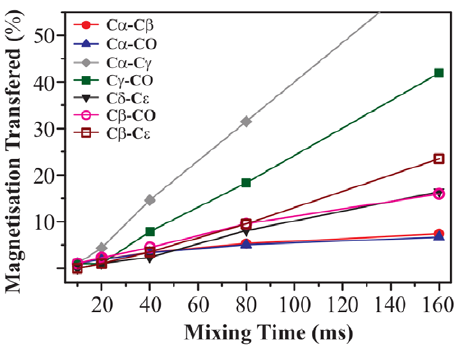
Figure 10. Mixing-time effect. Effect of mixing-time period on magnetisation transfer efficiency for different cross-peaks of U- 13 C-, 15 N- L-histidine : H 2 O at 11.74 T. For each cross-peak, M values were calculated for each mixing time using Eq. 1. All M values obtained for a particular cross-peak are normalised with respect to that obtained at t m =10 ms in case of C a -C b , C c -CO, C a -C c , C a -CO, and C b -CO cross-peaks, and at t m =20 ms for C d -C e and C b -C e cross-peaks. All measurements were made at 30 kHz of MAS using PARIS-xy (m=1)(N=1/2) recoupling scheme and an RF amplitude of 30 kHz.